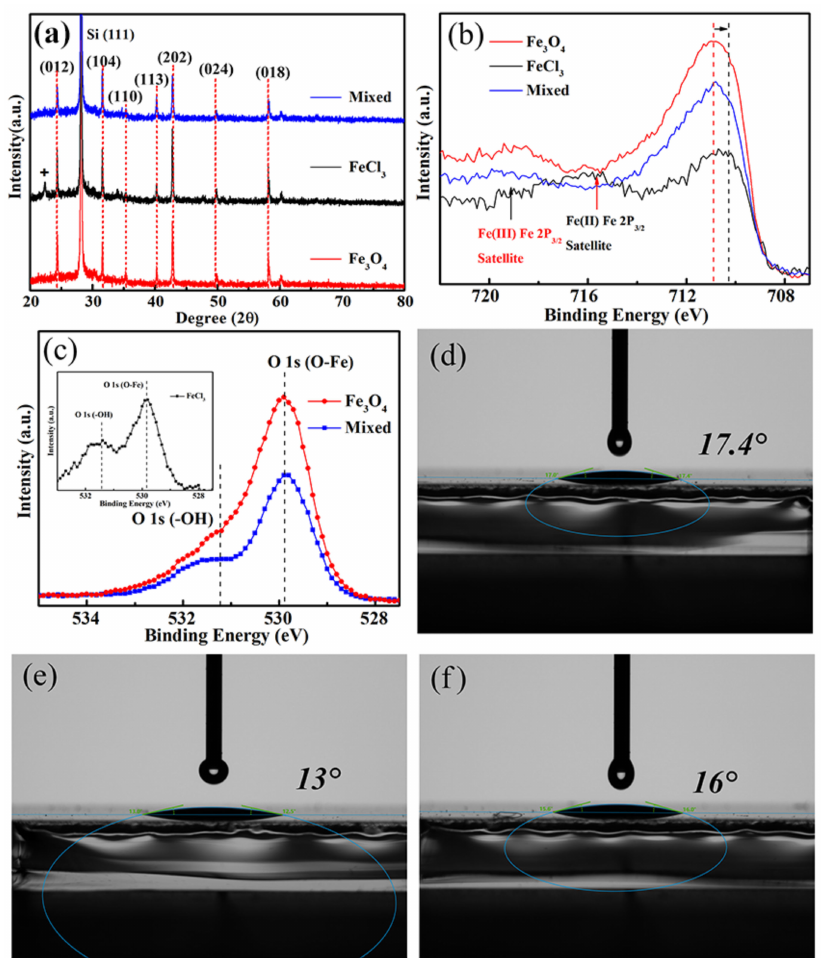
Figure 2. ( a ) XRD patterns, XPS spectra of ( b ) Fe 2P 3/2 and ( c ) O 1s of Fe 2 O 3 films prepared by FeCl 3 solution, Fe 3 O 4 nanoparticles, and FeCl 3 /Fe 3 O 4 mixed solution, contact angle of Fe 2 O 3